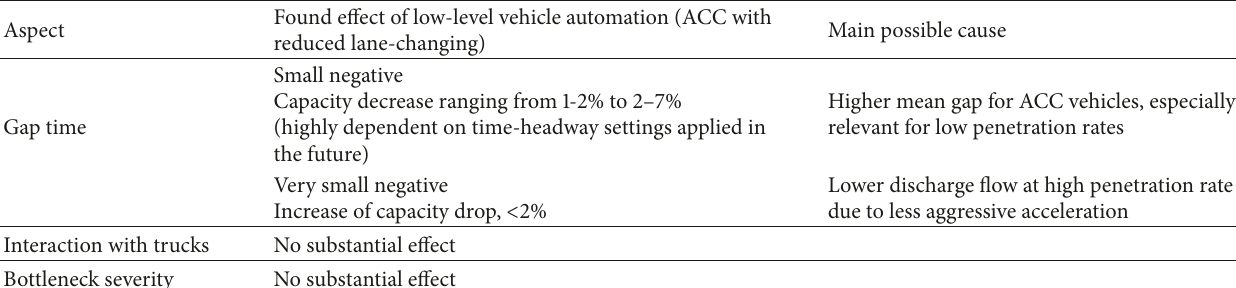
Table 4: Overall findings from the